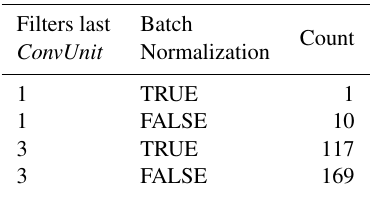
Table 4. Grouping of the transfer functions resulting in non-real number values in at least one pixel in the Eastern Ore Mountains do- main, according to number of filters in the last ConvUnit and batch normalization